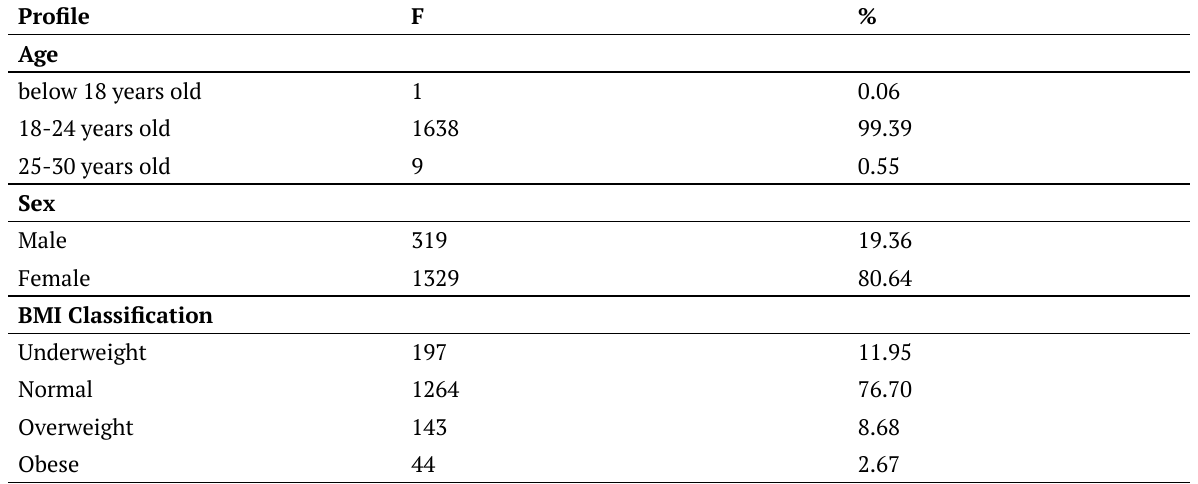
Table 1. Demographic profile of the respondents